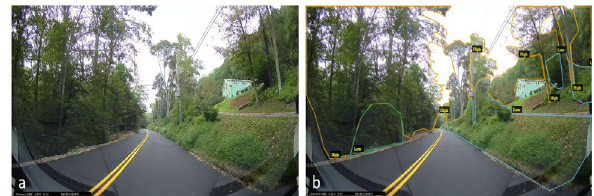
Figure 2: a) A video frame from the dashcam b) Annotated image into different classes using VGG image annotator